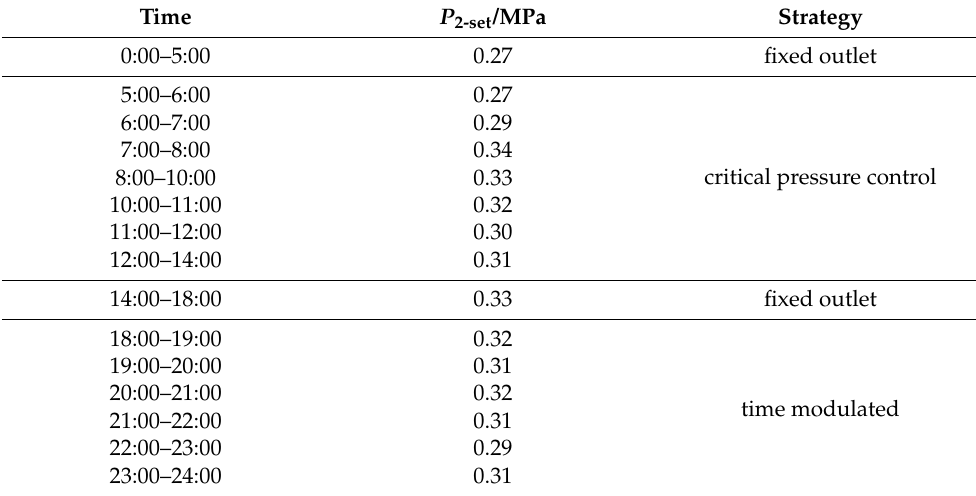
Table 9. S-cell regulating